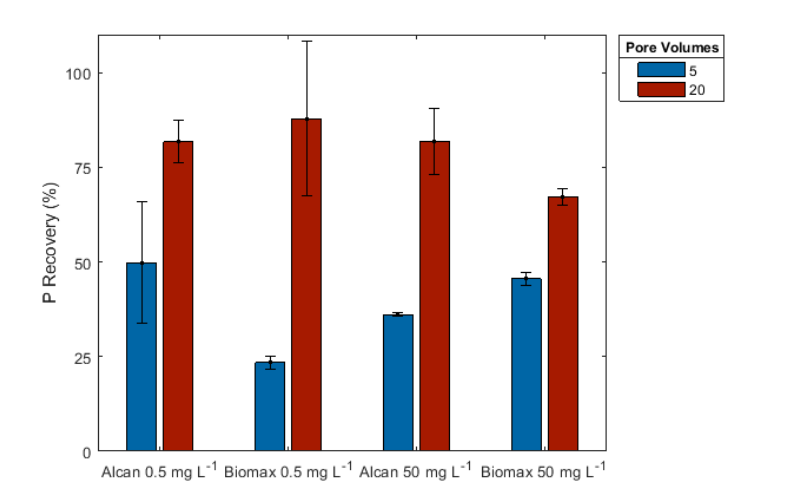
Figure 6. Effects of regenerative solution pore volume (PV) on phosphorus (P) recovery from P sorption materials (PSMs). Phosphorus recovery is shown after the first sorption cycle (S0-D0) only, treated with 1 M KOH at a residence time of 0.5 min with no recirculation. Treatments separated based on PSM type and P concentration used during the sorption